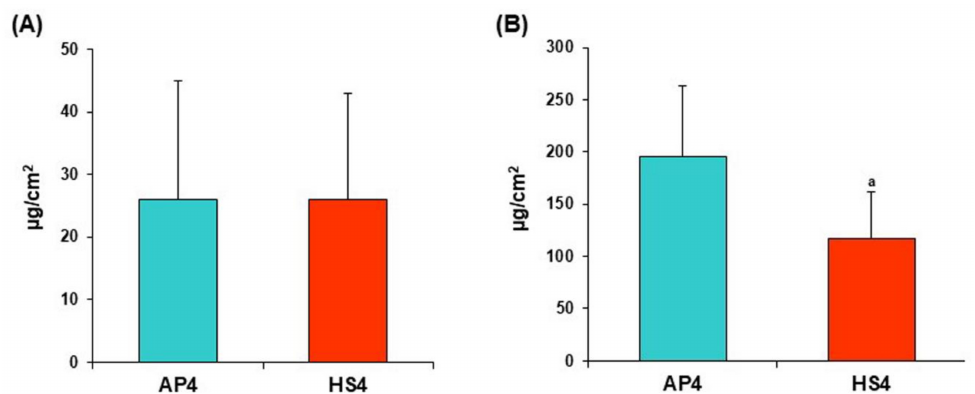
Figure 14. The serum proteins adsorption expressed per unit surface area by AP4 and HS4 gel beads incubating for 4 ( A ) and 24 h ( B ) in Hanks’ solution supplemented with 10% FBS. The data are presented as the mean ± S.D. (n = 5). a p < 0.05 vs. the corresponding AP4 gel beads.